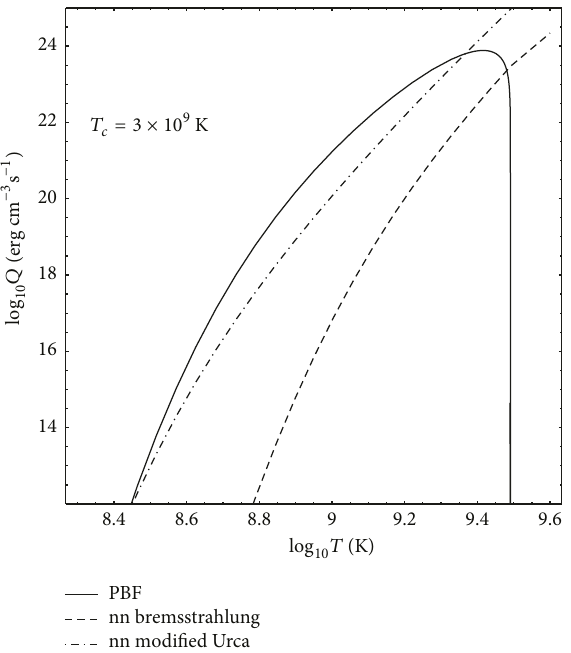
Figure 3: PBF neutrino emissivity versus temperature 𝑇 in com- parison with the modified Urca and bremsstrahlung emissivities at 𝑘 = 1.7 퐹